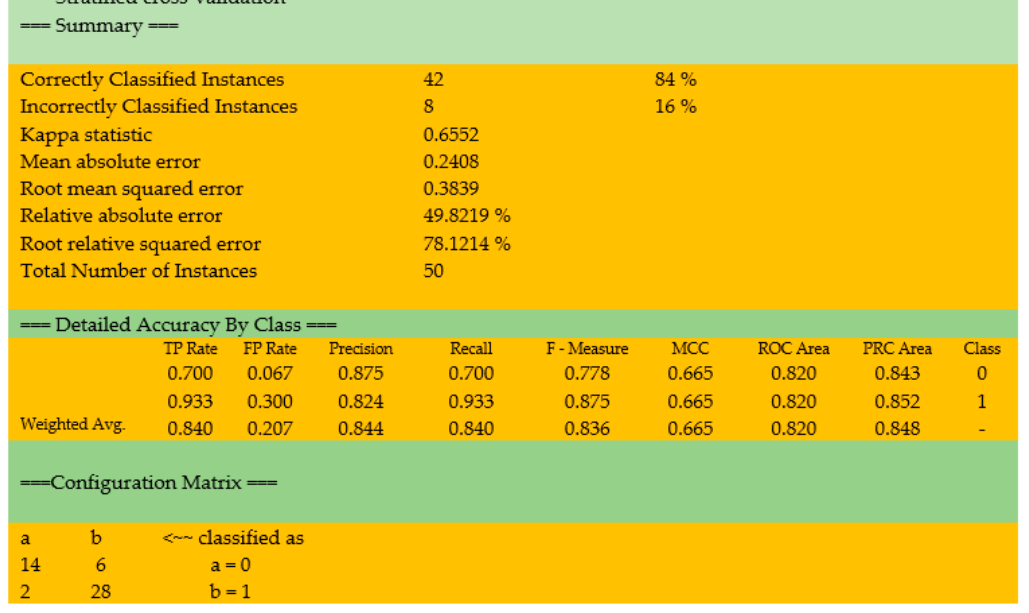
Table 2. WEKA Confusion Matrix